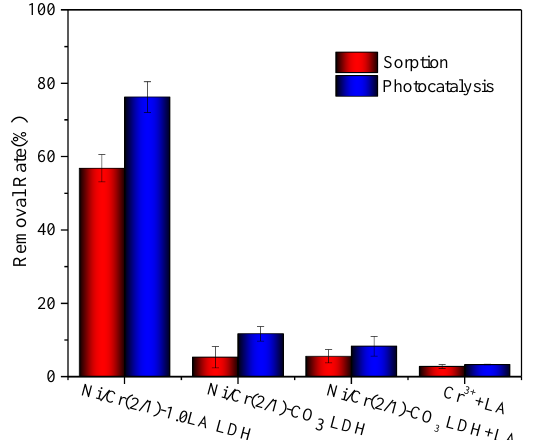
Figure 5. Photocatalytic degradation of MO over Ni/Cr(2/1) − 1.0LA LDH, Ni/Cr(2/1) − CO 3 LDH, Ni/Cr(2/1) − CO 3 LDH+LA − and Cr 3+ +LA − .